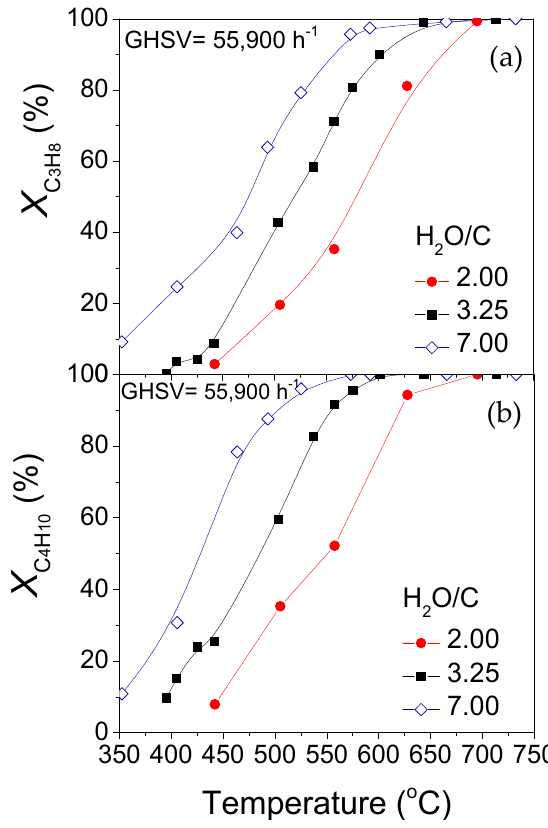
Figure 4. Effect of H 2 O/C ratio on the conversions of ( a ) C 3 H 8 and ( b ) C 4 H 10 obtained as a function of reaction temperature over 0.5%Rh/TiO 2 catalyst. Experimental conditions: GHSV: 55,900 h − 1 ; particle diameter: 0.15 < d p < 0.25 mm; feed composition: 2.0–5.7% C 3 H 8 , 0.1–0.3% C 4 H 10 , 0.15–0.20% Ar, 36.8–44.1% H 2 O (balance He).